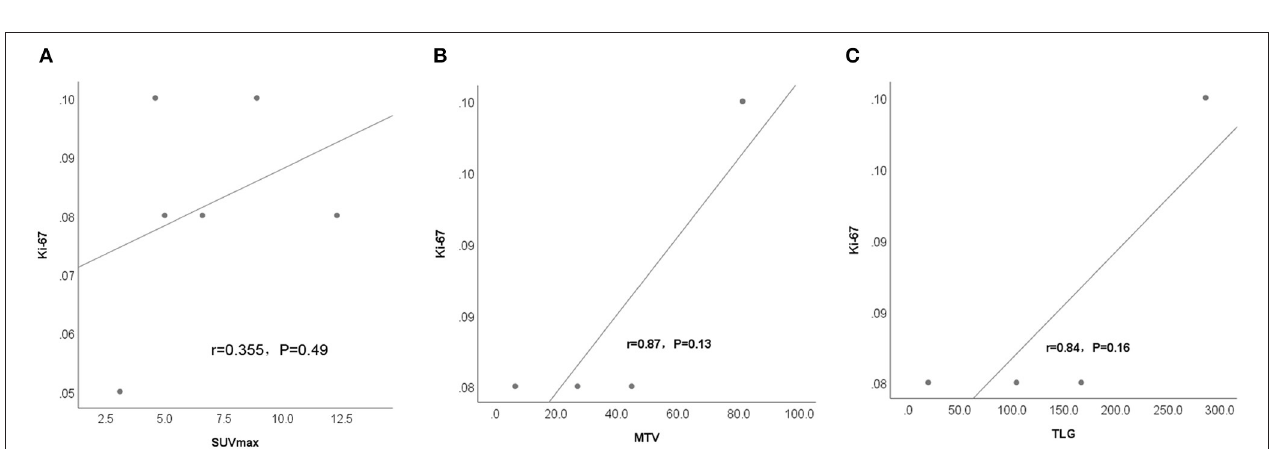
FIGURE 2 | 18 F-FDG PET/CT in three patients with primary thymic MALT lymphoma. (A) Male, 47y, Ki-67 = 8%, SUV max = 7.17, TLG = 99.85, MTV = 24.14 (B) Male, 31y, Ki-67 = 10%, SUV max = 6.08, TLG = 280.93, MTV = 80.02 (C) Female, 47y, Ki-67 = 8%, SUV max = 12.34, TLG = 35.54, MTV = 5.14.